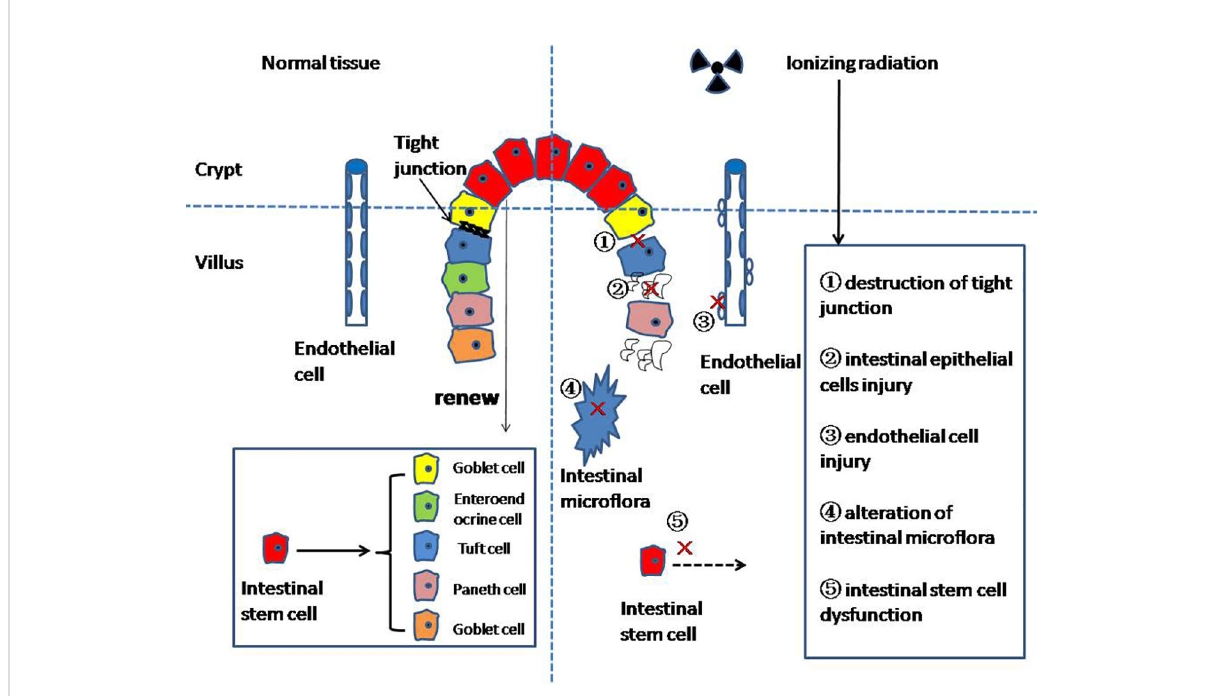
FIGURE 1 The mechanism of radiation